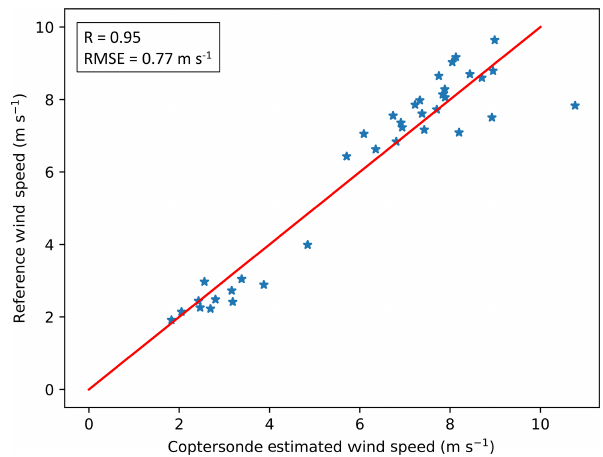
Figure 9. Example of CopterSonde wind speed calibration against 1min Oklahoma Mesonet 10m anemometer measurements. The red line represents the 1-to-1 line for reference. This statistical fit pro- duces a correlation coefficient of 0.95 and root mean squared error of 0.77ms − 1 compared to the Mesonet